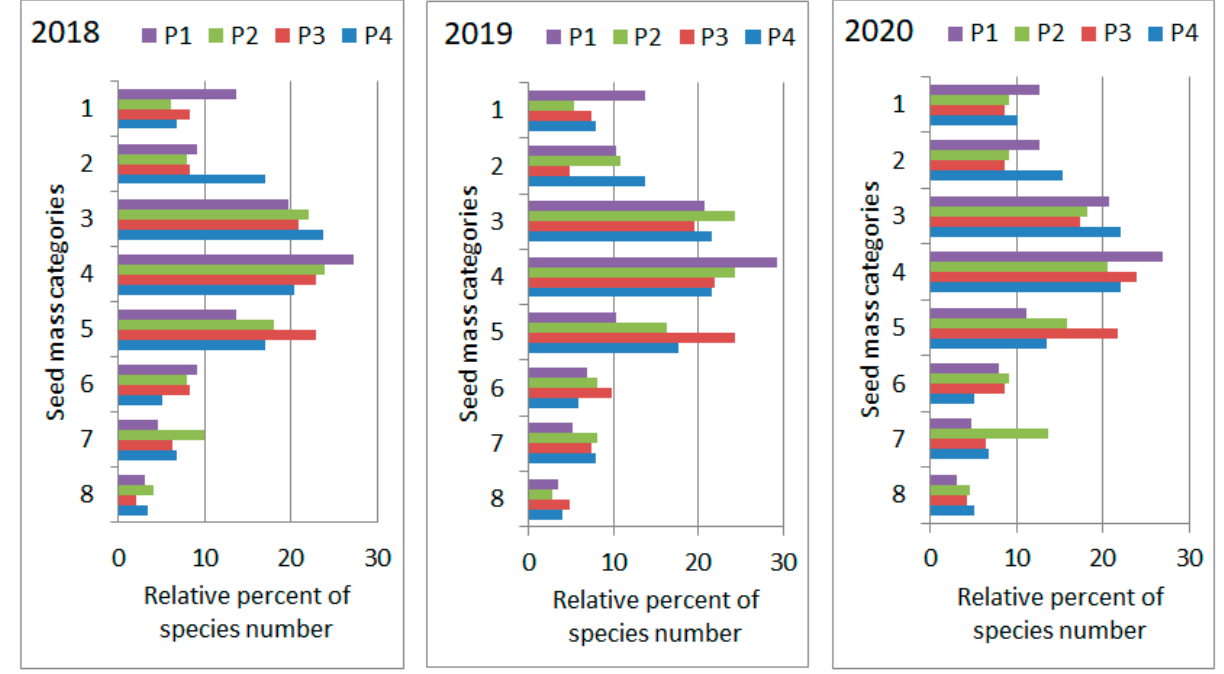
Figure 5. Distribution of species along seed weight categories in the four plots (P1–P4) of “Pócalja” Natura 2000 loess grassland (Central Hungary), in years 2018, 2019 and 2020.